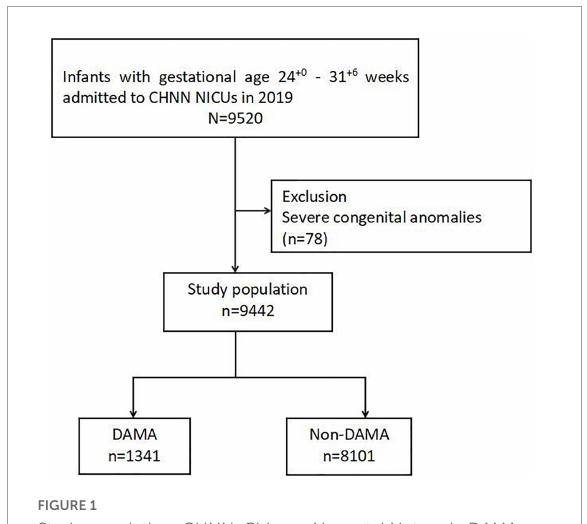
FIGURE1 Study population. CHNN, Chinese Neonatal Network; DAMA, discharge against medical advice; NICU, neonatal intensive care unit.